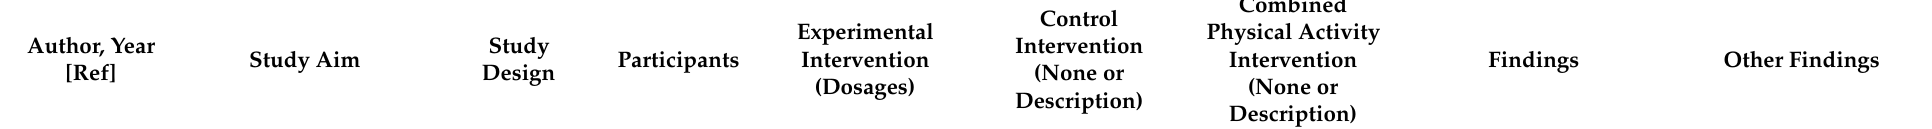
Table 1. Main characteristics of nutrikinetic and nutridynamic